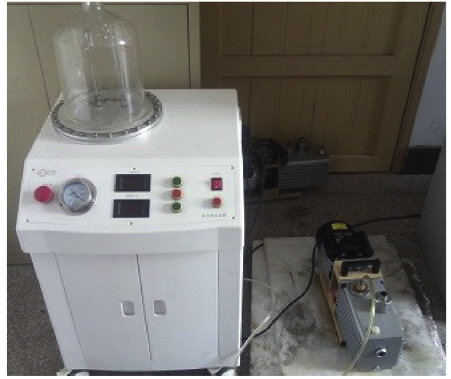
Figure 3: The vacuum saturation device. Table 2: FID sequence